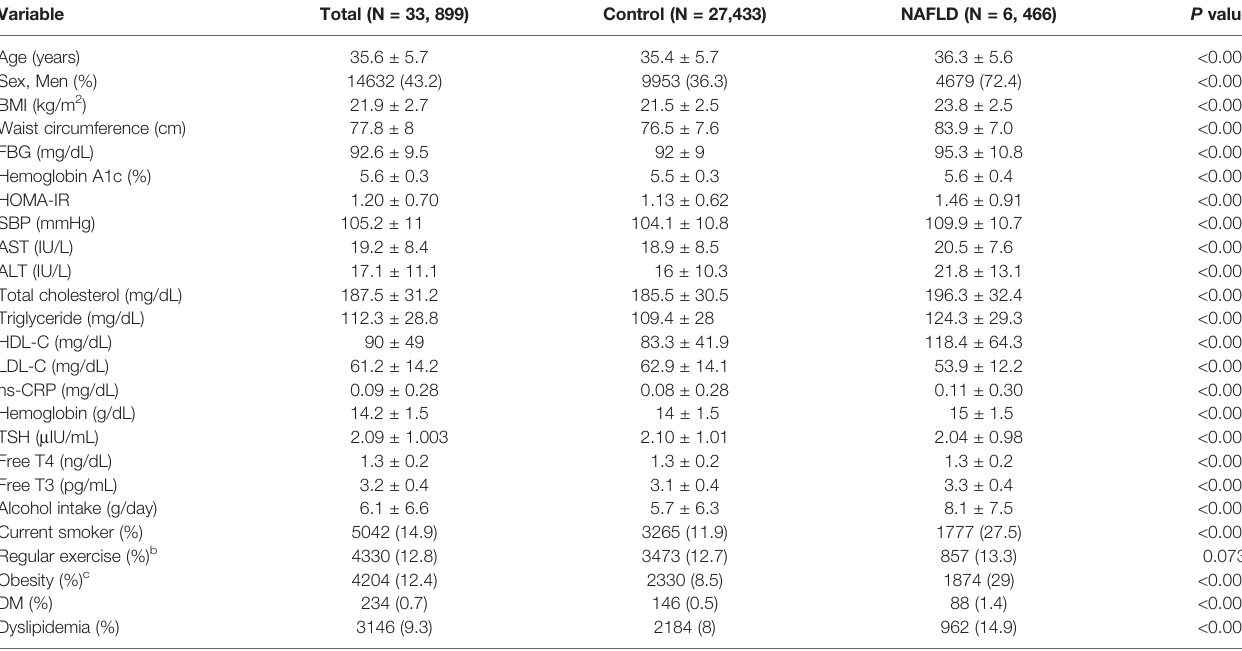
TABLE 1 | Baseline characteristics of participants according to development of non-alcoholic fatty liver disease. Variable